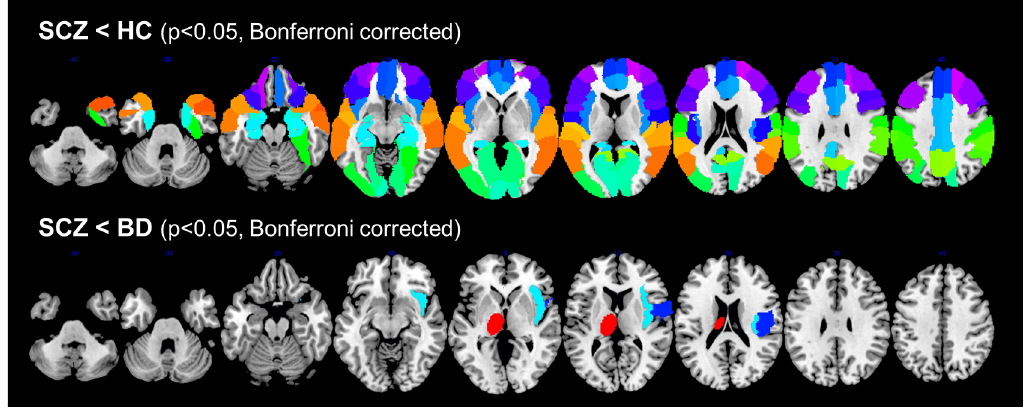
Fig 2. Results of the ROI analysis of Dataset1.AAL regions with significant GMV differences between SCZ, BD and HC (p < 0.05,Bonferroni corrected). ROI: regionof interest. AAL: Automated Anatomical Labeling.GMV: gray matter volume. SCZ: schizophrenia. BD: bipolardisorder. HC: healthy